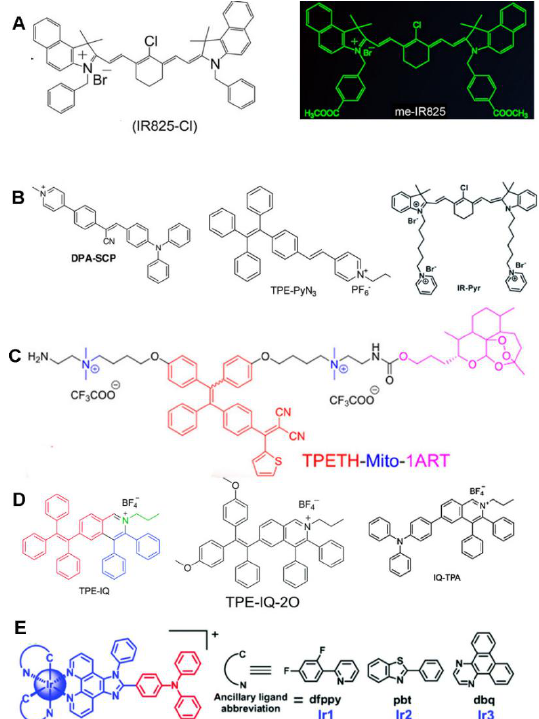
Figure 2. Non-TPP lipophilic cations for mitochondria-specific PT. ( A ) Cyanine dyes. Reprinted with